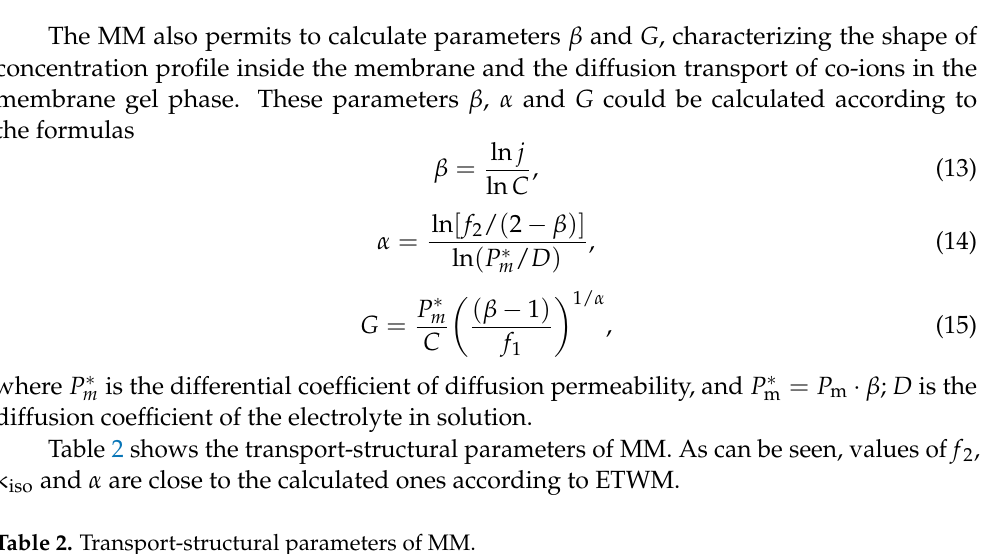
Table 2. Transport-structural parameters of